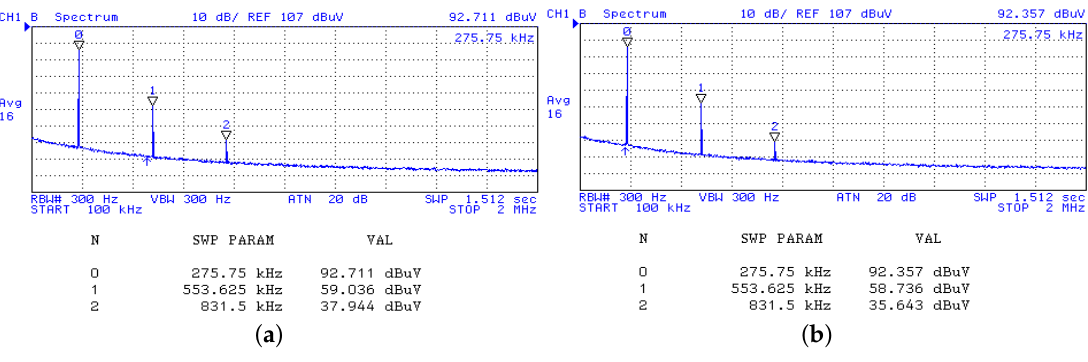
Figure 7. Measured Fourier spectrum of the output signals: ( a ) V o1 , ( b ) V o2